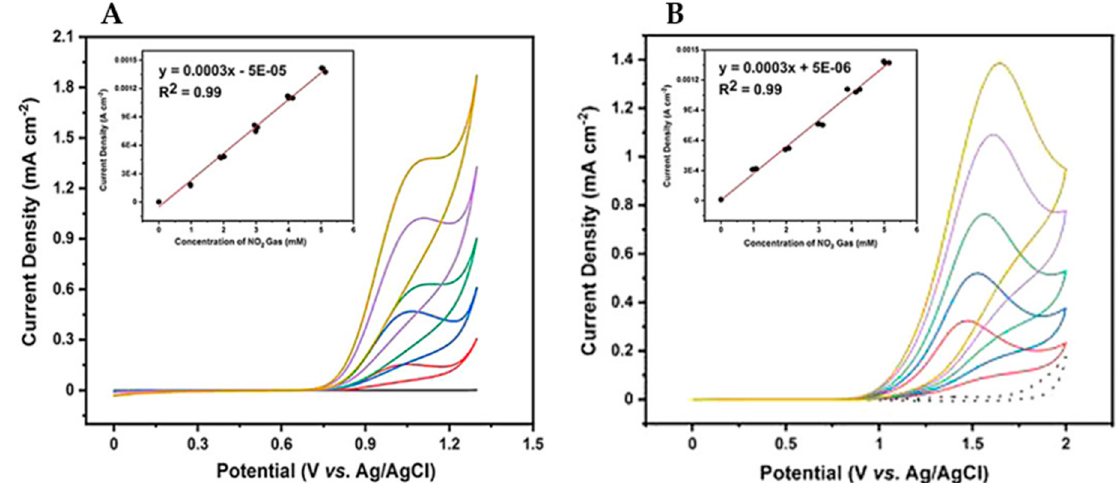
Figure 14. ( A ) Cyclic voltammograms in the concentration range of ~1 to 5 mM NO 2 in a 0.1 M KClO 4 solution at potentials of +1.1 V (vs. Ag/AgCl) and ( B ) +1.5 V (vs. Ag/AgCl) (insets: plots of current versus NaNO 2 concentration) (reproduced with the permission of